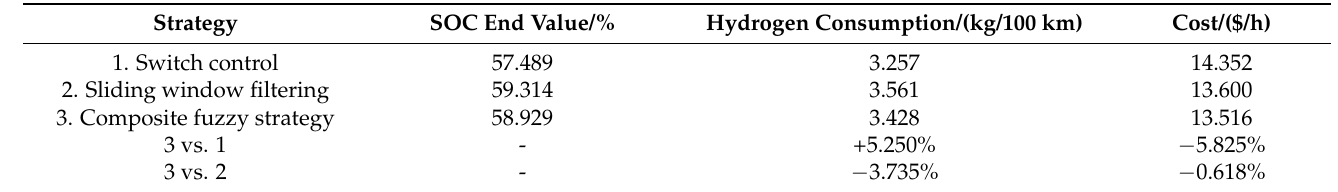
Table 4. Comparison of economy and durability under different strategies.